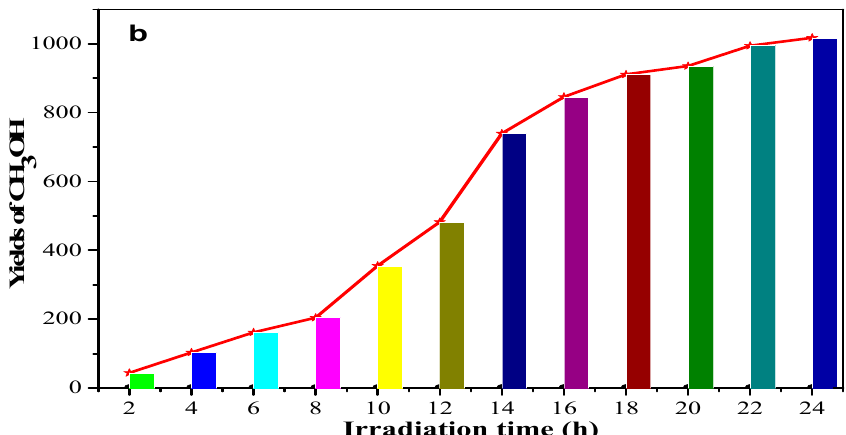
Figure 6. ( a ) Influence of irradiation time on conversion of benzylamine and selectivity of corresponding imine with CuW 0.7 Mo 0.3 O 4 (x = 0.7); ( b ) yields of CH 3 OH production as a function of irradiation time.